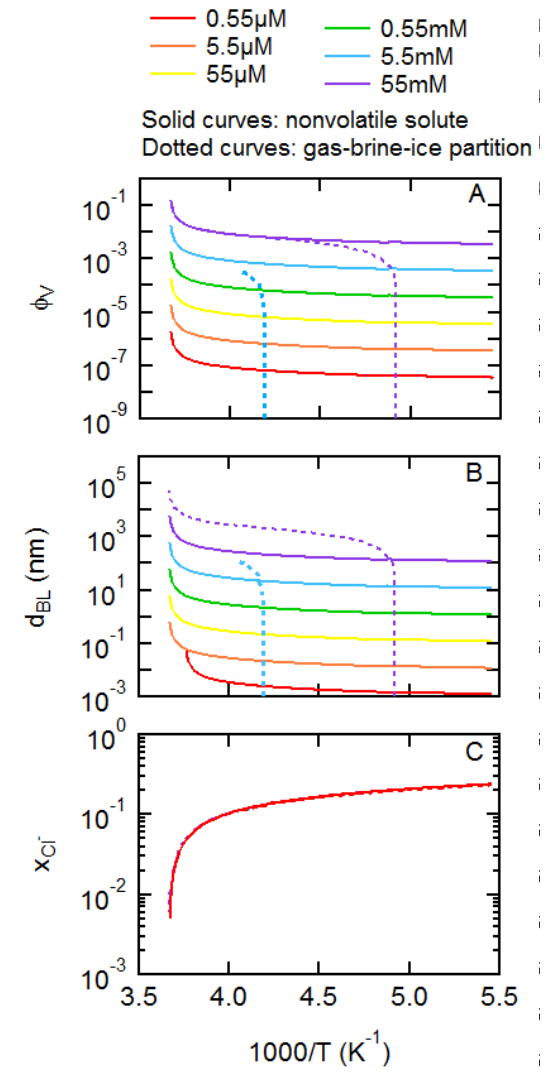
Fig. 6. Model prediction of (A) brine volume fraction, (B) brine thickness calculated assuming spherical ice crystals, 1mm in radius and (C) chloride mole fraction in the brine at different chloride con- centrations in the melt and at a range of temperatures using the full model which accounts for non-ideal behavior. The solid lines rep- resent the non-volatile solute scenario. The dotted lines represent a partitioning scenario based on gas-brine and gas-ice